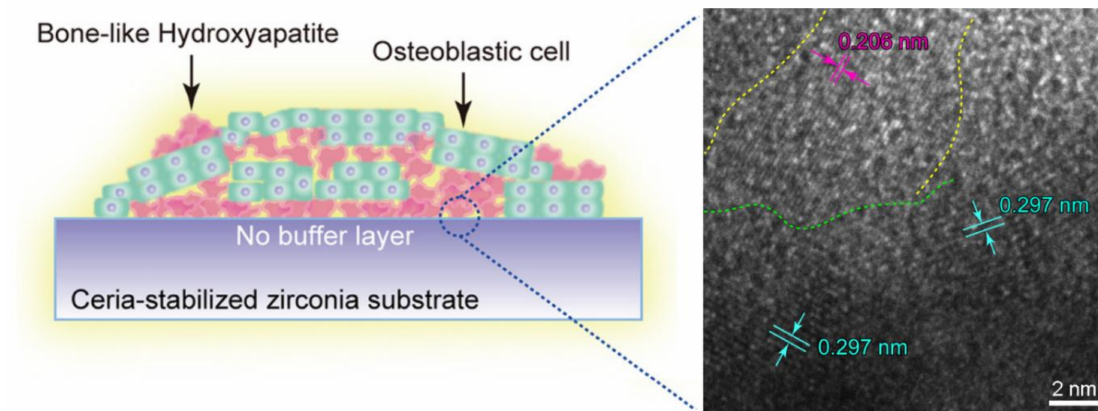
Figure 13. ( a ) Schematic representation of osteoblasti-cell (green) deposited hydroxyapatite (pink) into a ceria-zirconia substrate. ( b ) HR-TEM micrograph of the interface (green-dotted line) between the hydroxyapatite nanofibers (d = 0.206 nm of (400) face, magenta) and the zirconia nanocrystal (d = 0.297 nm of (101) face, cyan) at the nanoscale. Reproduced from [183], Copyright © 2021, with permission from